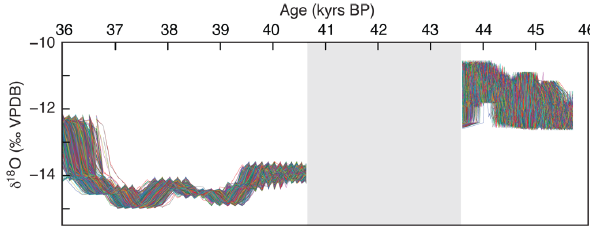
Fig. 9. Possible proxy record realizations for TSAL-1: illustration of 2000 MC realizations of the δ 18 O record for TSAL-1 (using cubic interpolation). The hiatus is shaded in the figure.